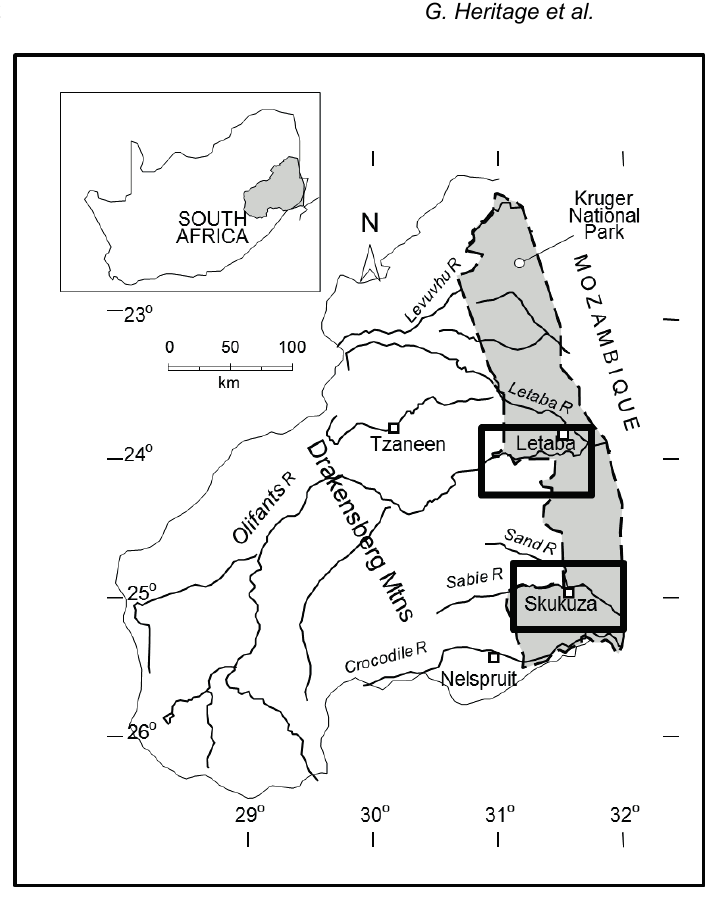
Fig. 1. Location of Sabie and Olifants rivers in north-eastern South Africa. Black boxes indicate the extent of the study